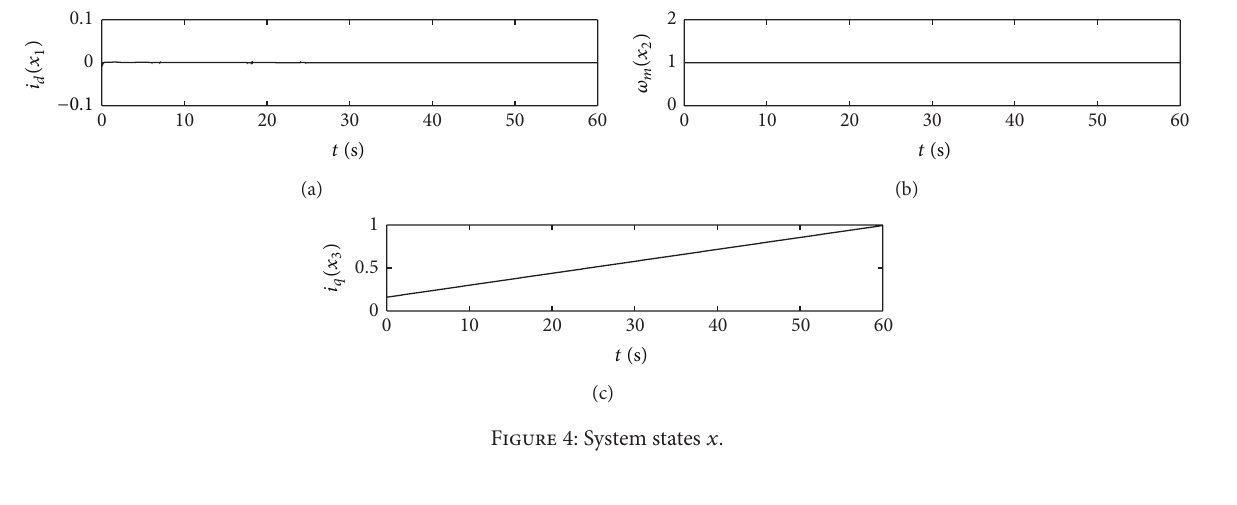
Figure 4: System states 𝑥